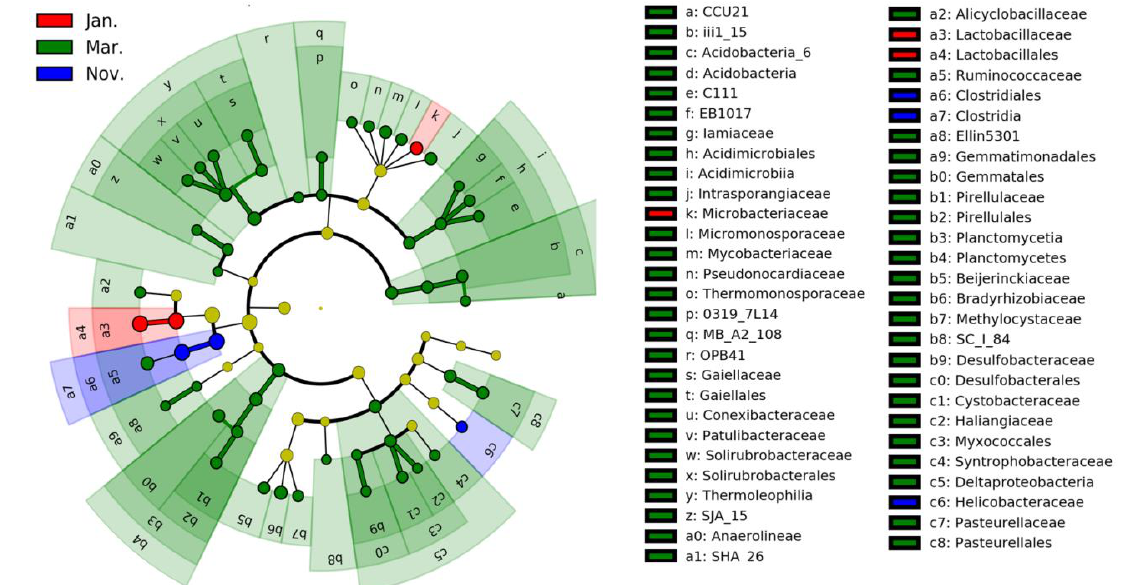
Figure 3. Linear discriminant analysis (LDA) effect size (LEfSe) analysis of the intestinal bacterial biomarkers of hooded cranes among the 3 months. Identified phylotype biomarkers were sorted by effect size and the alpha value was <0.05. Each filled circle represents one biomarker. The cladogram represents the taxonomic hierarchical structure of the phylotype biomarkers identified over the 3 months; blue, phylotypes statistically overrepresented in November; red, phylotypes statistically overrepresented in January; green, phylotypes statistically overrepresented in March. Table 1. Similarity percentage (SIMPER) analysis of the bacterial contribution to the difference for different months. ASV, amplicon sequence variant.